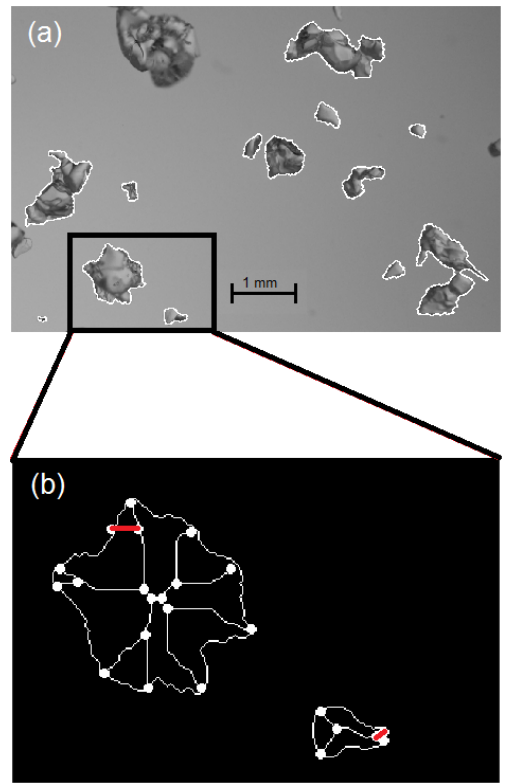
Figure 6. Example of a segmented image from 29 December 2009: the segmented outlines are overlaid with the original image (a) , and two detected particles are magnified (b) to illustrate the skeleton (inner white lines), the skeleton endpoints (white dots at the particle border), and branch points (white dots along the junction nodes of the skeletons). The shortest of the skeleton branches, defined here as the Euclidean distances between endpoints and nearest branch point, are marked in red and correspond to the SSK